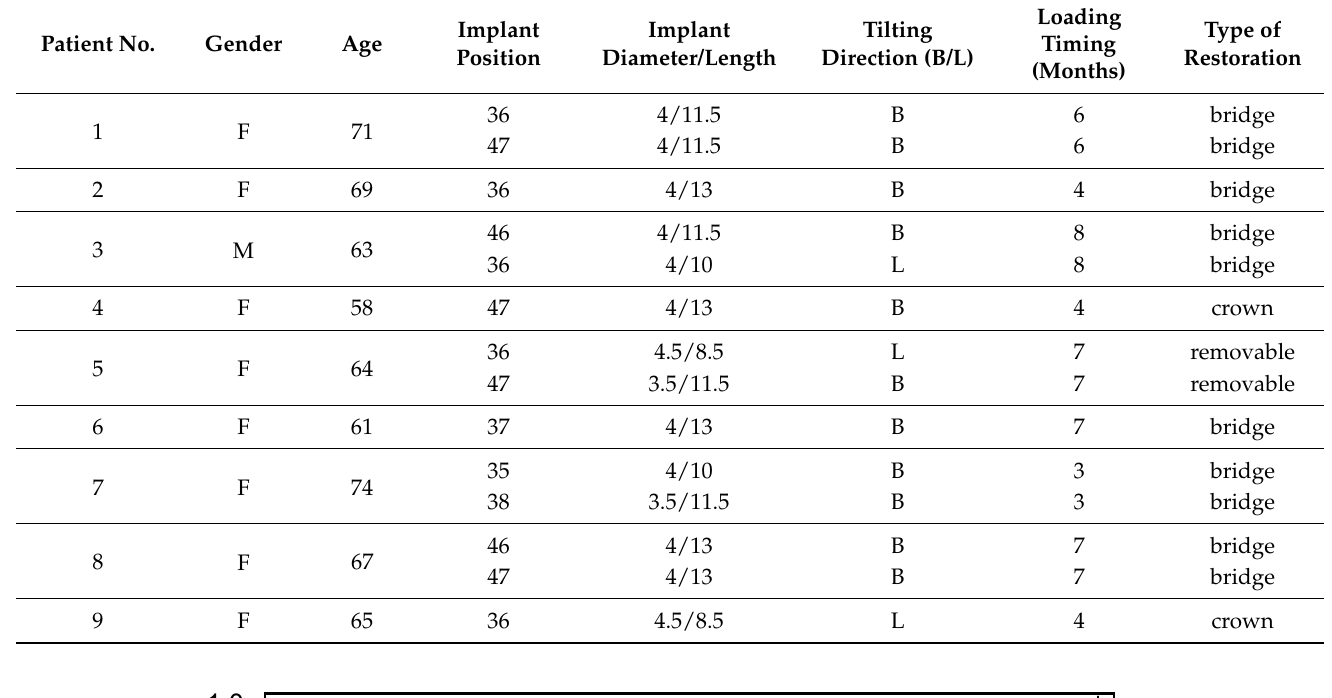
Table 1. Distribution of